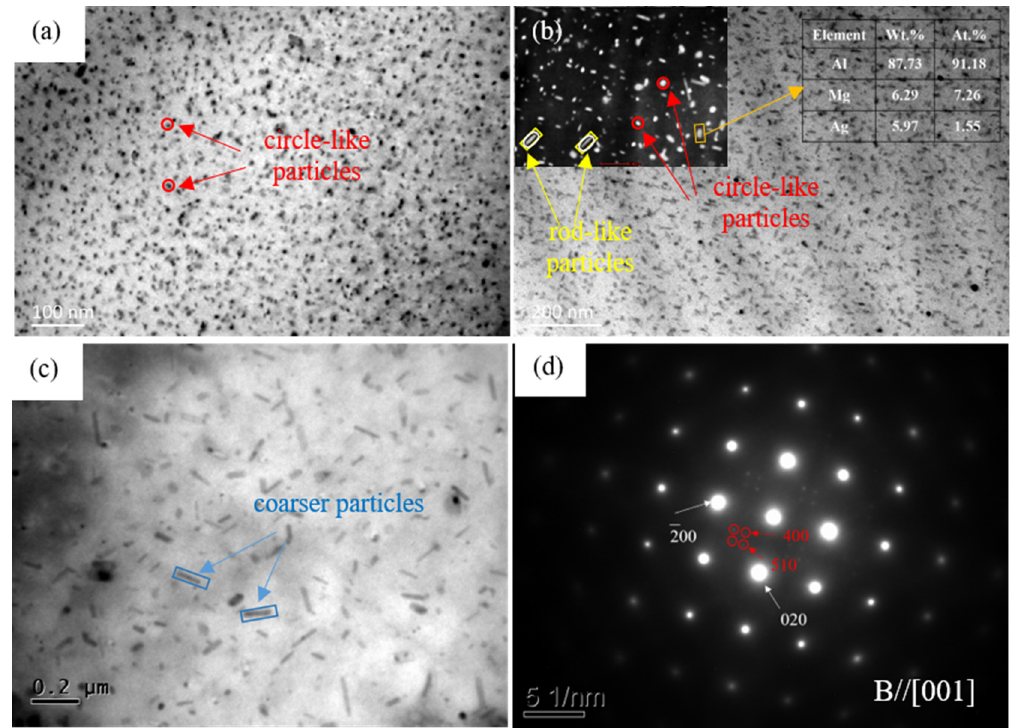
Figure 5. TEM micrographs of Al-4Mg-0.6Ag alloy: ( a ) aged for 1 h, ( b ) aged for 8 h, ( c ) aged for 32 h at 210 °C, respectively; ( d ) SAED pattern of the rod-like particles.